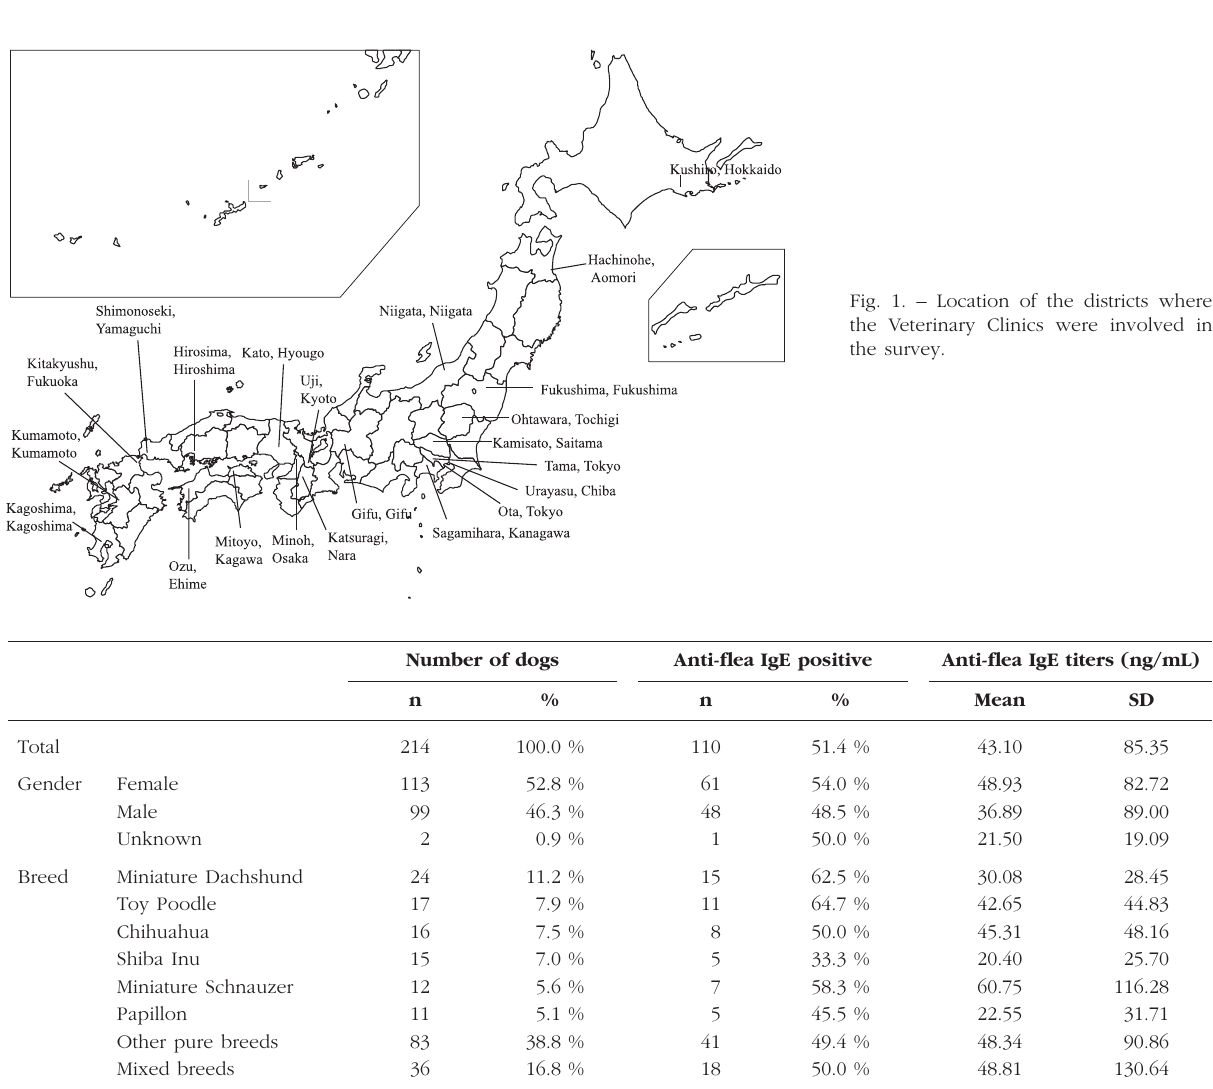
Table I. – Profile and IgE positive rate in the 214 examined dogs.